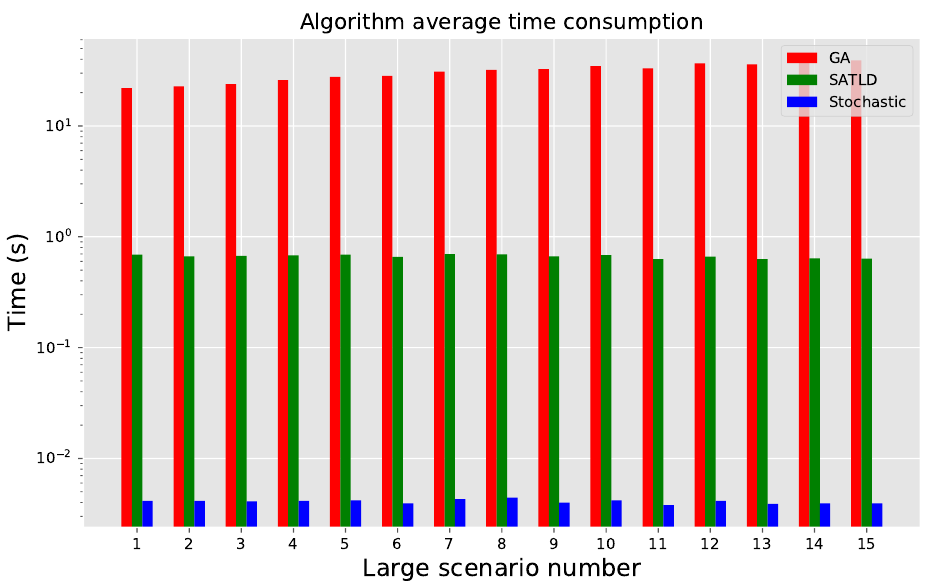
Figure 11. Average time consumption in large